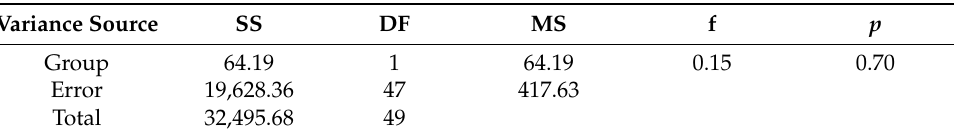
Table 5. ANCOVA results on learning effectiveness between the two groups. Variance Source